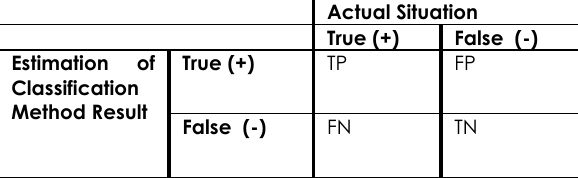
Table 1. The classification matrix used in the